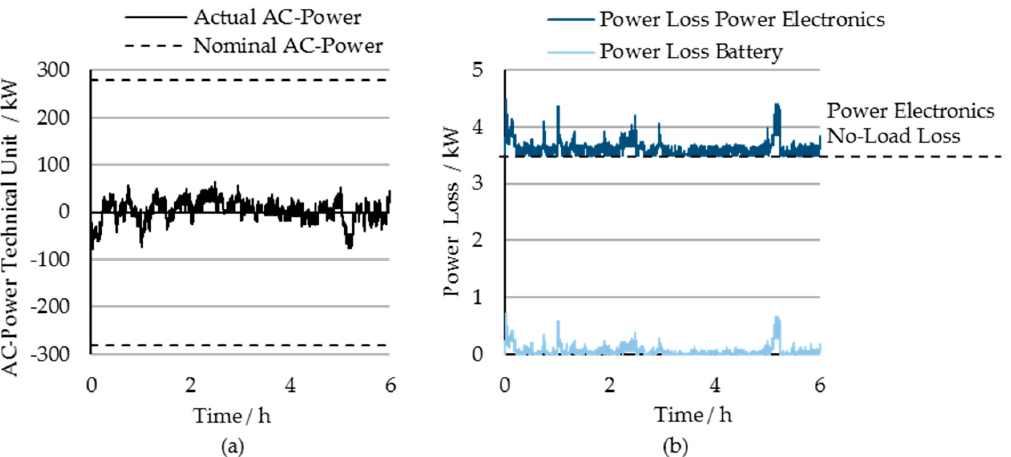
Figure 6. Time series analysis for load profile and power loss for a single Technical Unit (TU 6) during an arbitrary six-hour timeframe: ( a ) measured AC-power ( P > 0: Charge, P < 0 : Discharge); and ( b ) simulated power losses in power electronics and battery.